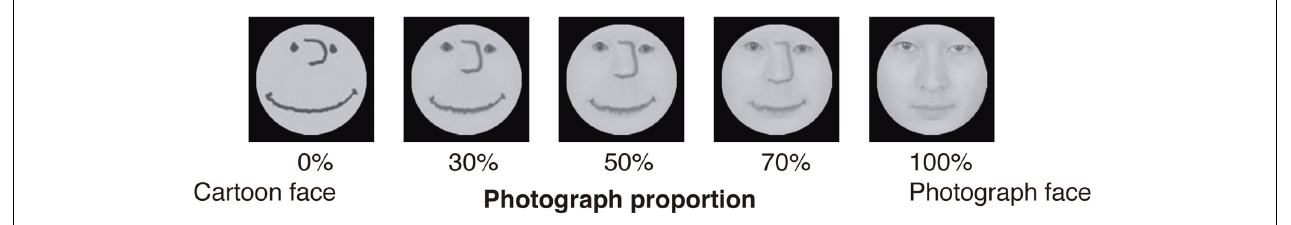
FIGURE 2 | The stimuli used in Experiment